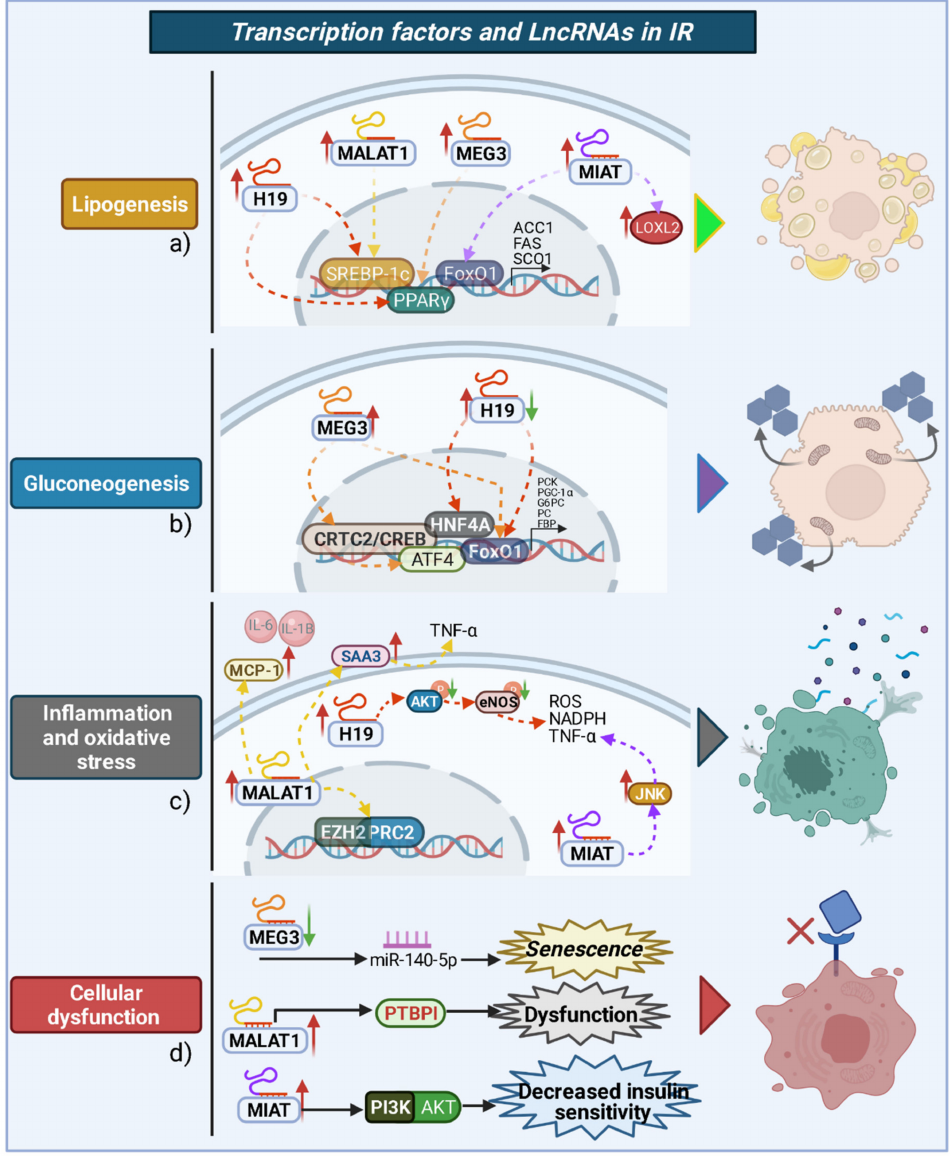
Figure 4. lncRNAs and transcription factors related to the development of IR. ( a ) Lipogenic activity is associated with elevated levels of H19, MALAT1, MEG3, and MIAT and their interaction with nuclear proteins, such as element-binding transcription factor 1c (SREBP-1c),